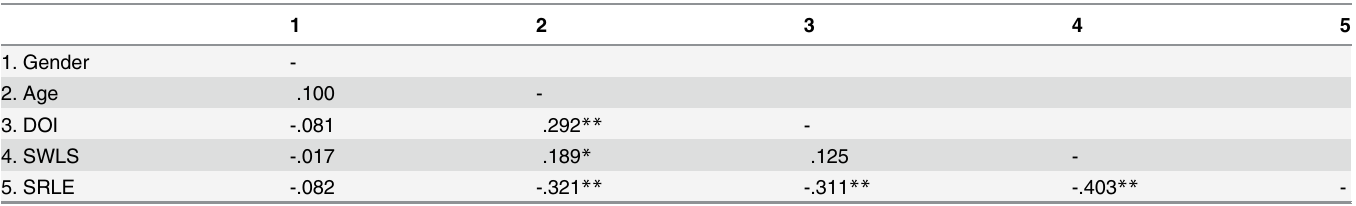
Table 2. Correlations — Study